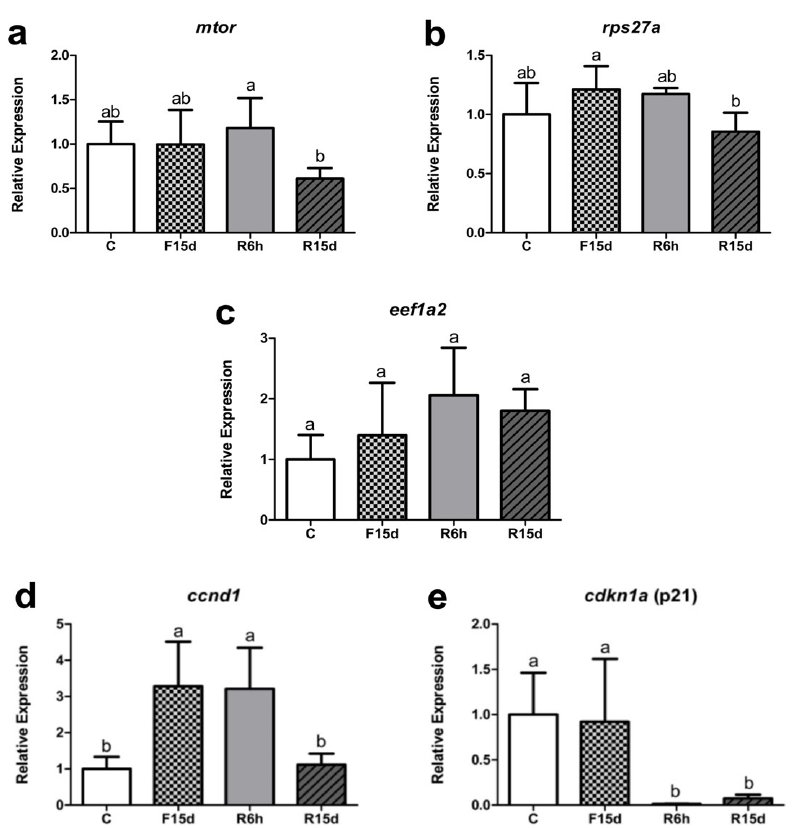
Figure 5. Relative mRNA expression of the mtor ( a ), rps27a ( b ), eef1a2 ( c ), ccnd1 (d) and cdkn1a ( e ) in late juvenile pacus. The genes were evaluated in the control (C), fifteen-day fasting (F15d), six-hours fasting (R6h), and fifteen-day refeeding (R15d) groups. Data are expressed as the fold change of group C and presented as the mean ± SD. Different letters indicate significant differences between groups ( p < 0.05 in a one-way ANOVA test, followed by Tukey’s multiple comparisons test for mtor , rps27a , ccnd1 , and cdkn1a or the Kruskal–Wallis and Dunn tests for eef1a2 , n = 5/group).